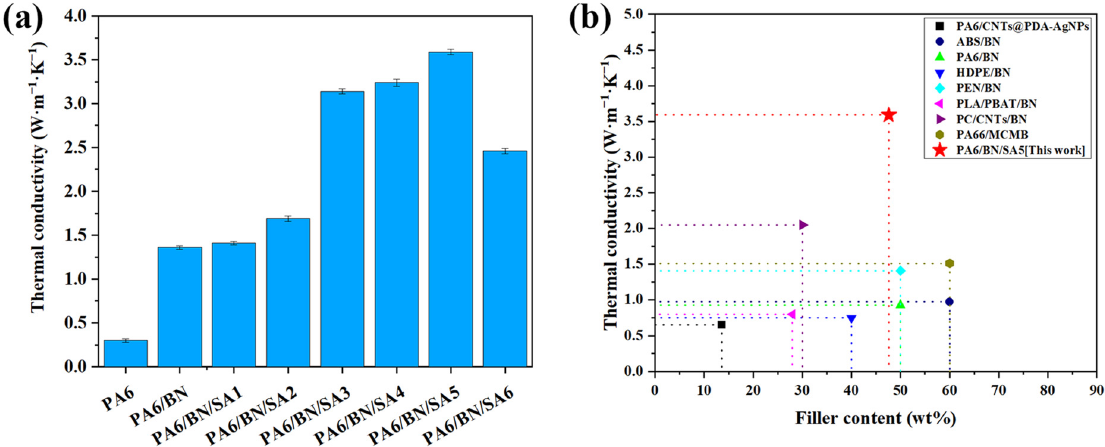
Figure 5. ( a ) Thermal conductivities of composites and ( b ) other composites prepared by melt- blending method [7,37–43].